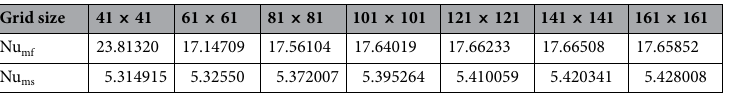
Table 2. Grid independence study using average Nusselt number (Nu) at a = 10, R d = 0.5, Gr = 10 3 , and Ri = 1 .